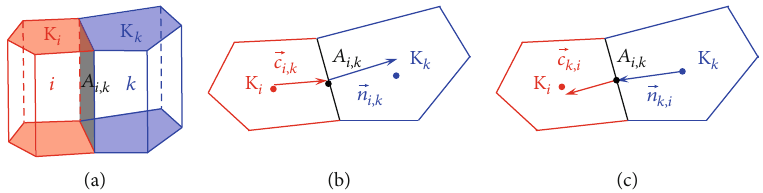
Figure 5: Two unstructured cells for calculating transmissibility in fi nite volume discretization. (a) Three-dimensional schematic of two adjacent unstructured cells. K is the permeability tensor of cell i , K is the permeability tensor of cell k , and A is the area of the interior i k i , k face between the two neighboring cells in (a). (b) Top view of (a) for calculating the one-sided transmissibility from cell i to cell k in fi nite volume discretization. c ! is the vector from the centroid of cell i to the centroid of the face between the two neighboring cells in (a); n ! i , k i , k is the normal from the centroid of the interior face to cell k . (c) Top view of (a) for calculating the one-sided transmissibility from cell k to cell i in fi nite volume discretization. n ! is the vector from the centroid of cell k to the centroid of the interior face between the two k , i is the normal from the centroid of the interior face to cell i adjacent cells in (a); c ! k , i